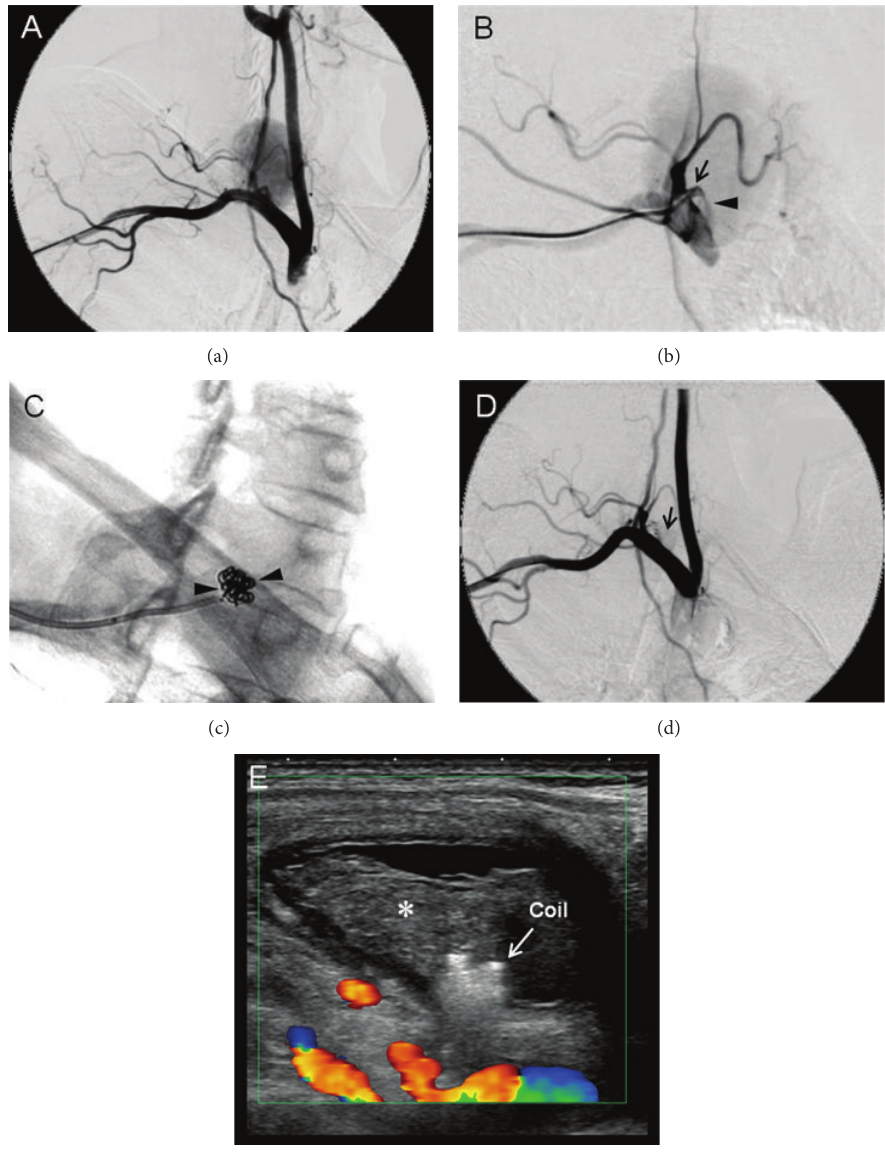
Figure 2: (a) Digital subtraction angiogram (DSA) in the right anterior oblique view showed a large PsA originating from the TCT. (b) Selective DSA of the PsA neck clearly showed the short narrow neck originating from the proximal side of the TCT root. (c) Coil embolization of the PsA. Arrowheads indicate the coils corresponding to the PsA neck. (d) DSA after coil embolization showed the near disappearance of the PsA, but faintly residual contrast dye was noted near the coil (arrowhead). (e) Duplex ultrasound following 15min ultrasound-guided compression. Complete disappearance of blood flow within the PsA and thrombus formation (asterisk) was